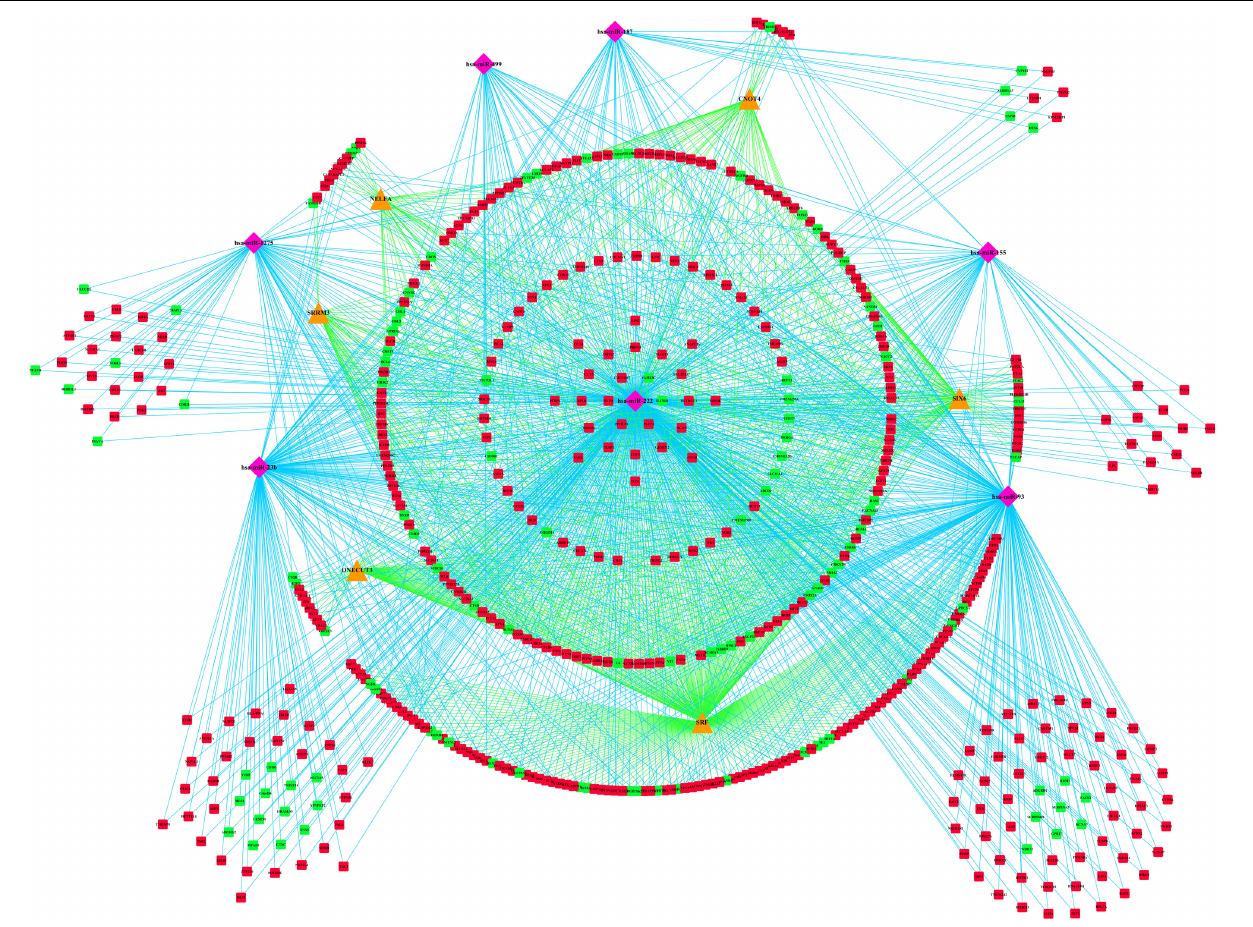
FIGURE 7 | miRNA–mRNA–TF regulatory network of differentially expressed genes (DEmRNAs). The pink diamonds represent miRNAs, orange triangles represent TFs, red circles represent upregulated genes, and green circles represent downregulated genes. TFs, transcription